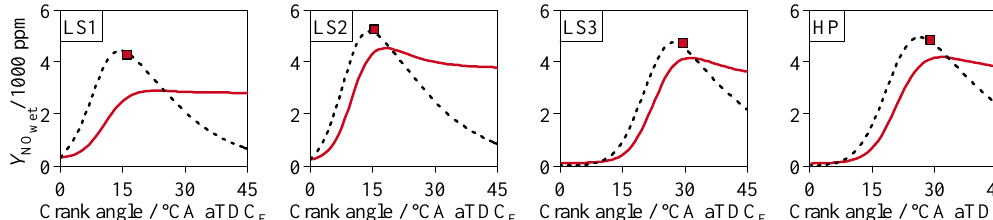
Figure A2. Comparison of in-cylinder NO-production prediction with a 0D two-zone GT-POWER model (v2019) using chemical kinetics (same mechanism used in 3D-CFD and provided in the Supplementary Materials, red continuous line) and chemical equilibrium calculations (from